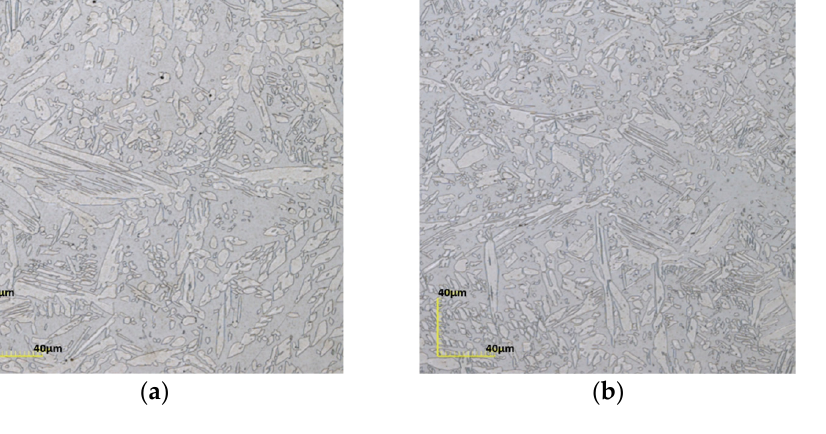
Figure 11. Microstructure observed in the HAZ of the sample subjected to postwelding solution heat treatment for 10 s at 1150 °C: ( a ) edge; ( b ) 1/4 region; ( c ) 1/2 region.